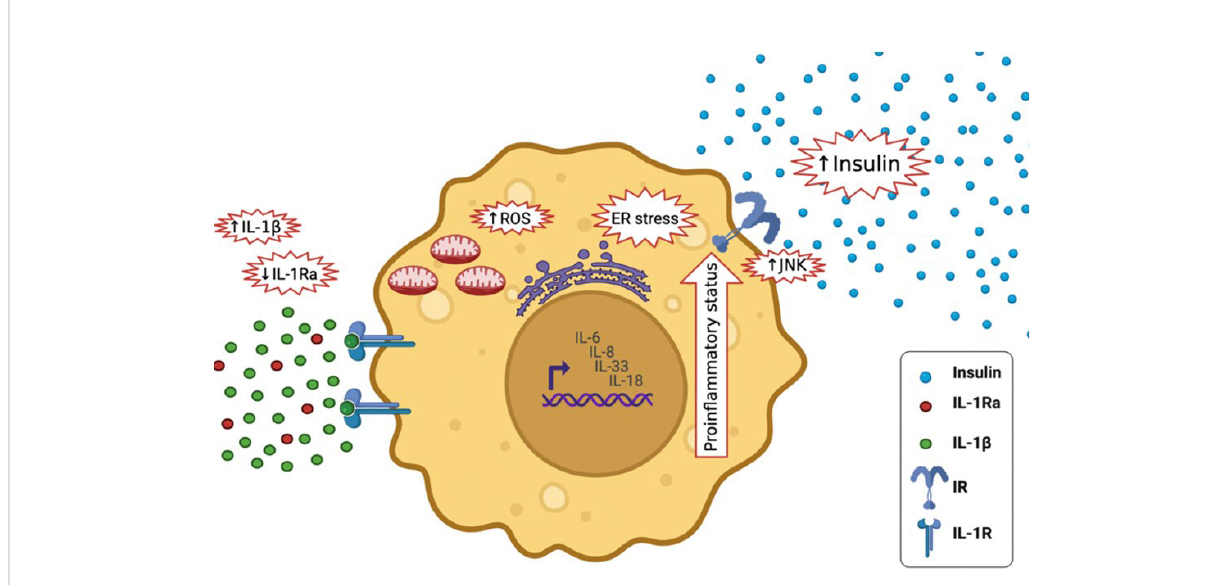
FIGURE 6 Effects of high IL-1 b in T2DM and lower levels of IL-1Ra; it activates the expression of other pro-in fl ammatory cytokines, including IL-6, IL-8, IL-33 and IL-18, It increases insulin secretion, it stimulates endoplasmic reticulum stress as well as oxidative stress (ROS generation), it stimulates c-Jun N-terminal kinases